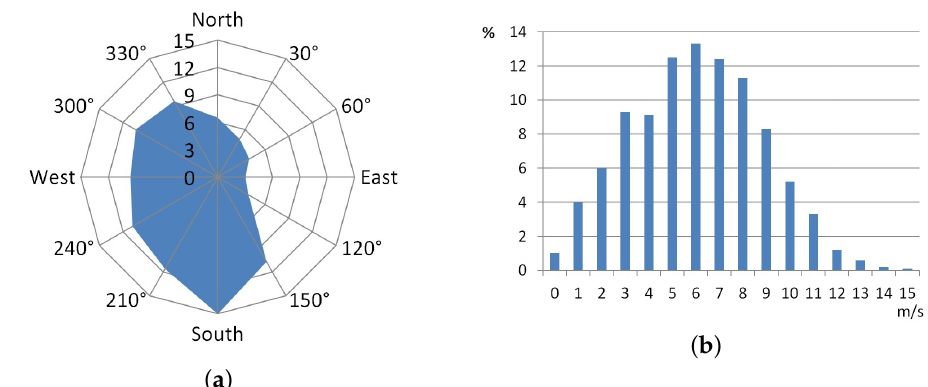
Figure 3. Wind data for 2020 at an altitude of 100 m from the surface. ( a ) The average annual wind rose; ( b ) the average annual wind speed in the wind farm area.